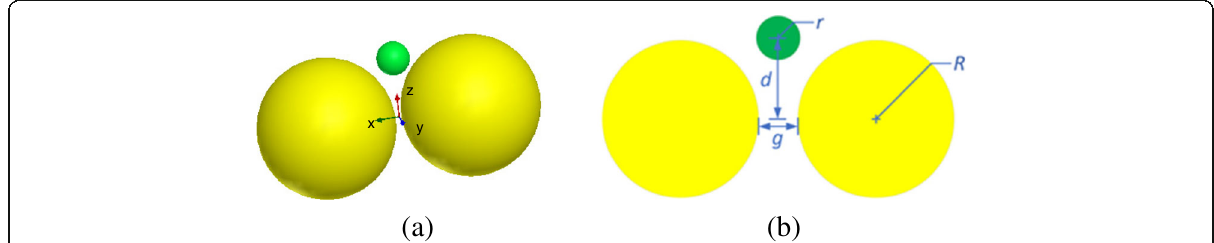
Fig. 5 Configuration of an optical trapping system of a gold nansphere dimer in water. a 3D view. b Front view and dimensions, where R = 25 nm, r = 5 nm, and g = 2